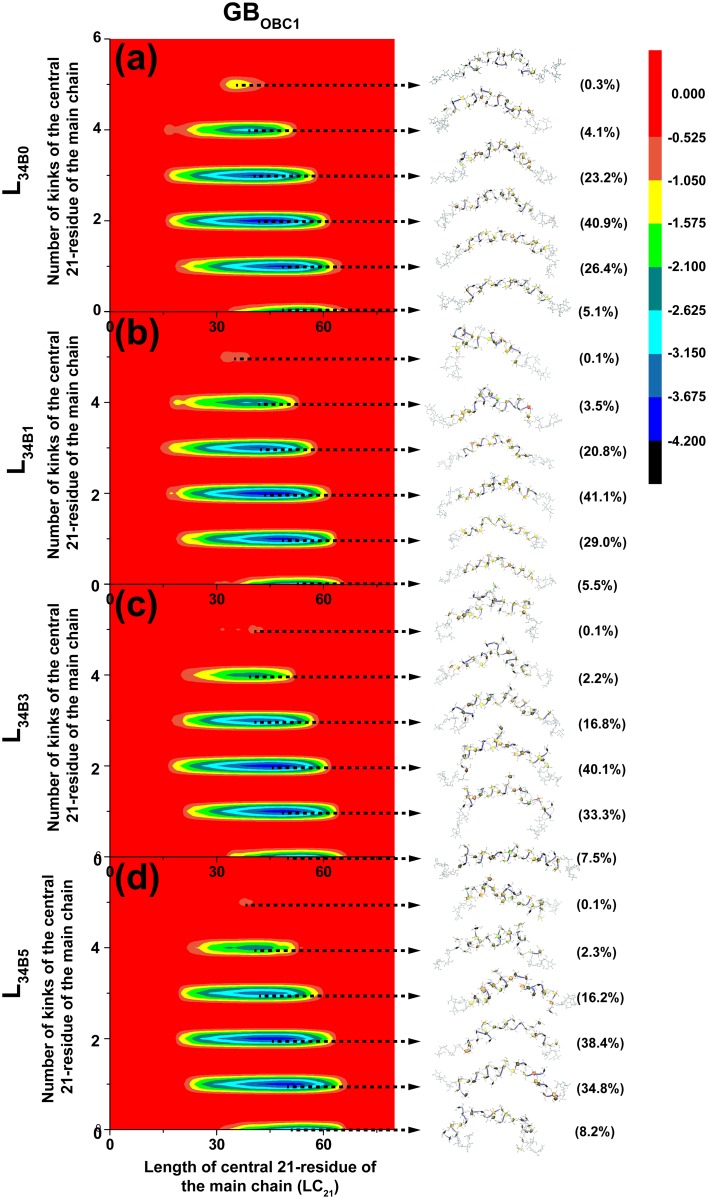
Relative free energy (kcal/mol) maps of L34B0 (a), L34B1 (b), L34B3 (c) and L34B5 (d) simulated in GBOBC1 model as characterized by number of kinks in the central 21 residue of the main chain and LC21.Their major representative conformers and populations are also shown.